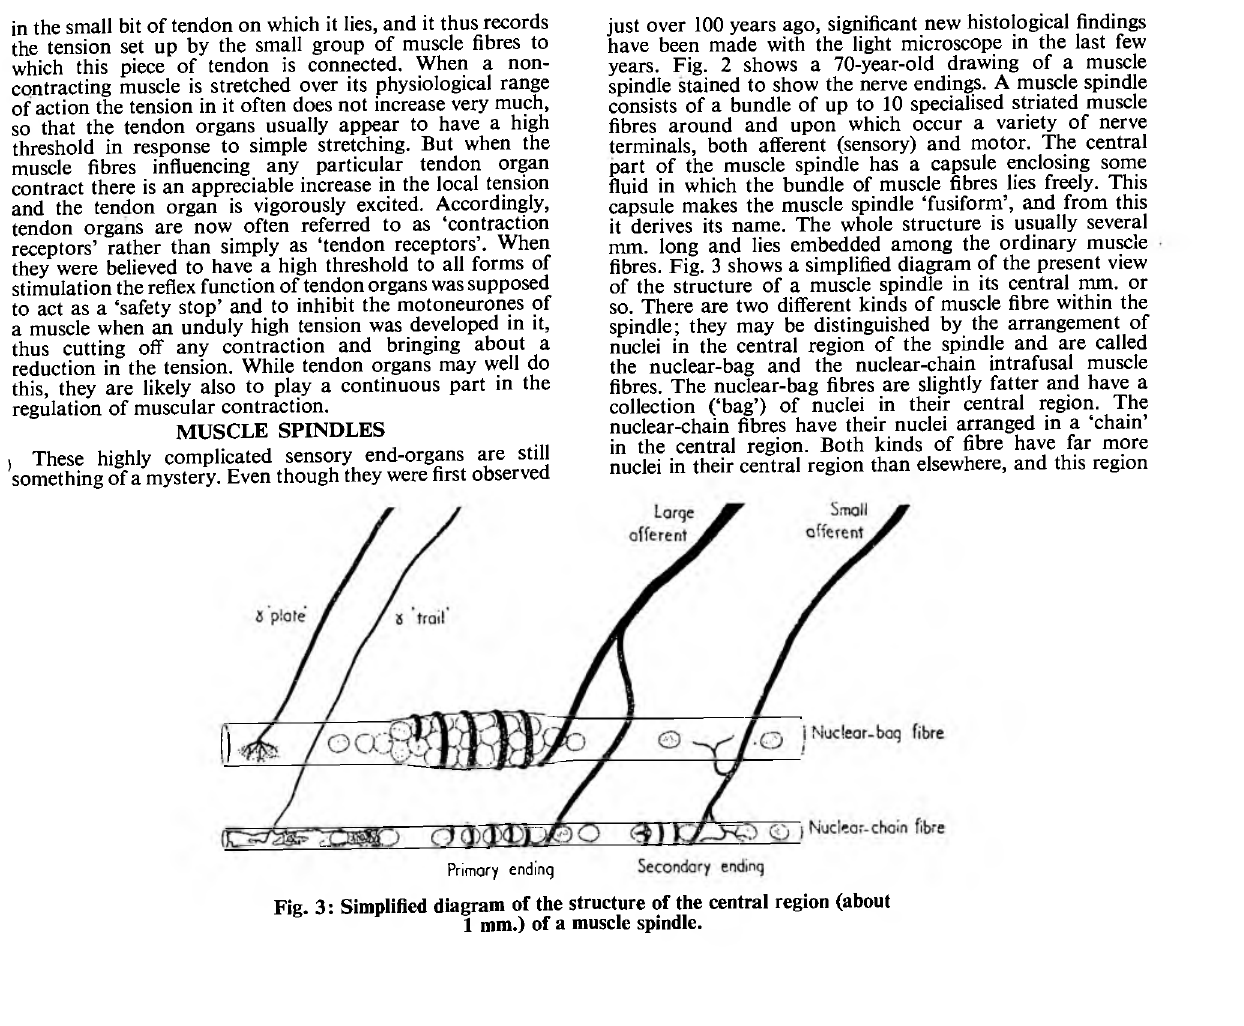
Fig. 2: A muscle spindle: (a) intrafusal muscle fibres; (b) nerve trunk supplying motor and sensory fibres to spindle.